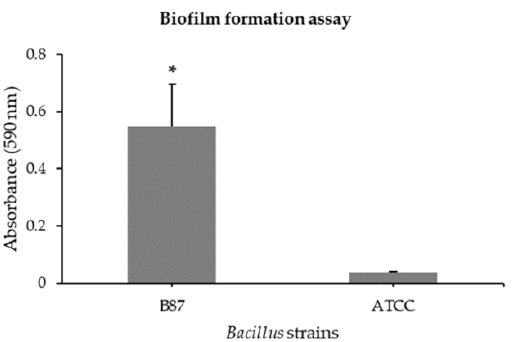
Figure 1. Biofilm formation assay of Bacillus sp. B87. Submerged biofilms of Bacillus sp. B87 and B. cereus ATCC 14579 were visualized via crystal violet staining. Data represent the mean of three independent experiments, each consisting of six internal replicates. Error bars indicate standard deviations. Statistical analysis includes Student’s paired t -test (* p < 0.01).